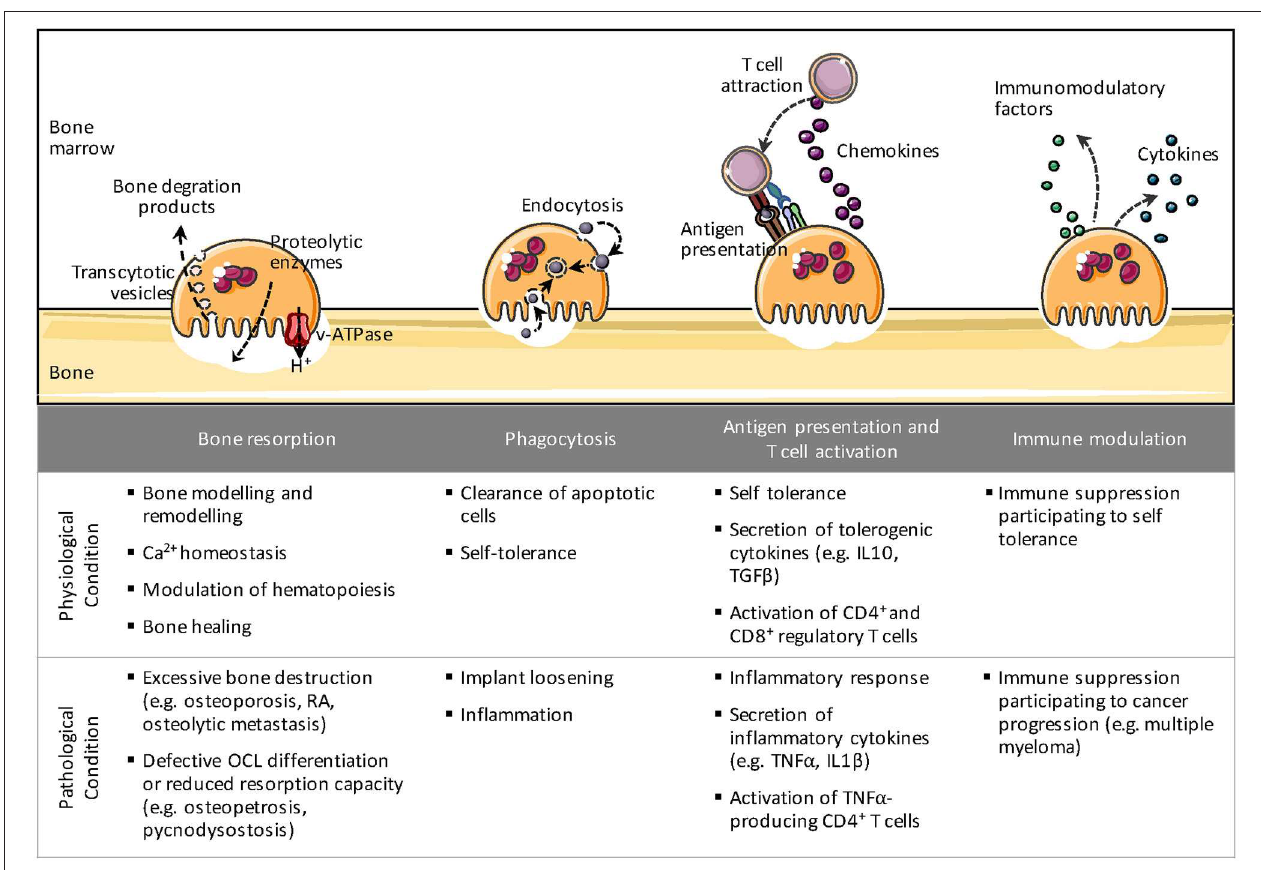
FIGURE 1 | The different immune-related roles of osteoclasts. Besides bone resorption, osteoclasts share many properties with their precursor cells such as phagocytosis, antigen presentation, and immune modulation. These immune-related functions may possess divergent functionalities under physiological and pathological